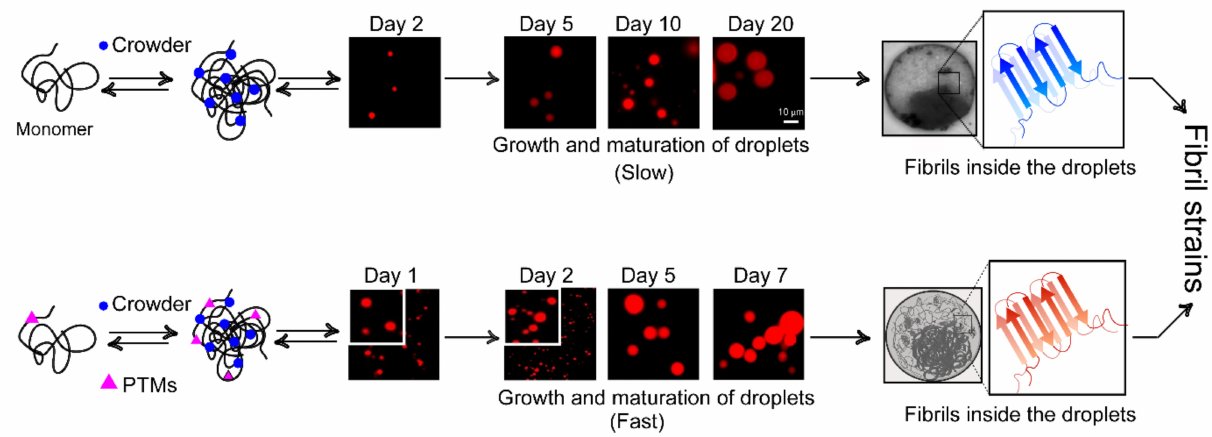
Figure 7. Formation of fibril strains under different phase-separating conditions. Upper panel shows the formation of labeled α -Syn droplets at day 2 and the subsequent transition of droplets from liquid to solid state over 20 days in the presence of molecular crowder PEG. Fibrils (illustrated in red) can be seen inside the droplet on day 20. Lower panel shows faster formation of S129E (a phosphomimetic mutant) α -Syn droplets at day 1. These droplets are bigger than that of the wild type and show faster growth and maturation (fibrils illustrated in blue). Fibrils arising under different LLPS conditions, like the presence of familial mutations, PTMs, small molecules, or metal ions can show polymorphism and represent distinct fibril strains. The fluorescence microscopy images and the TEM image of the droplets are adapted with permission from Soumik Ray et al., α -Synuclein aggregation nucleates through liquid–liquid phase separation, Nature Chemistry, (2020) Copyright @2020 Springer Nature